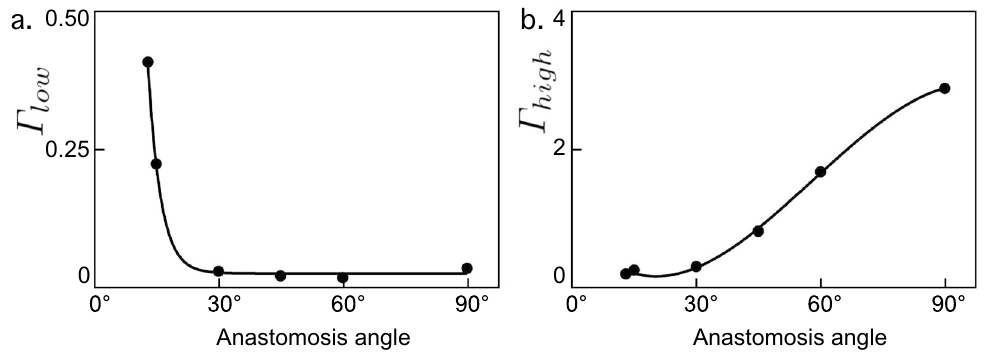
Figure 6. Summary metrics showing the degree to which differing anastomosis designs induced ( a ) pathologically low shear strain rates over the vein wall over the course of a single cardiac cycle, and ( b ) pathologically high shear strain rates over the vein wall over the course of a single cardiac cycle. These summary metrics suggested that the fraction of vein wall area experiencing pathologically high shear strain rates diminished with decreasing graft-to-vein anastomosis angle, while that experiencing pathologically low shear strain rates was low for anastomosis angles above 30 ◦